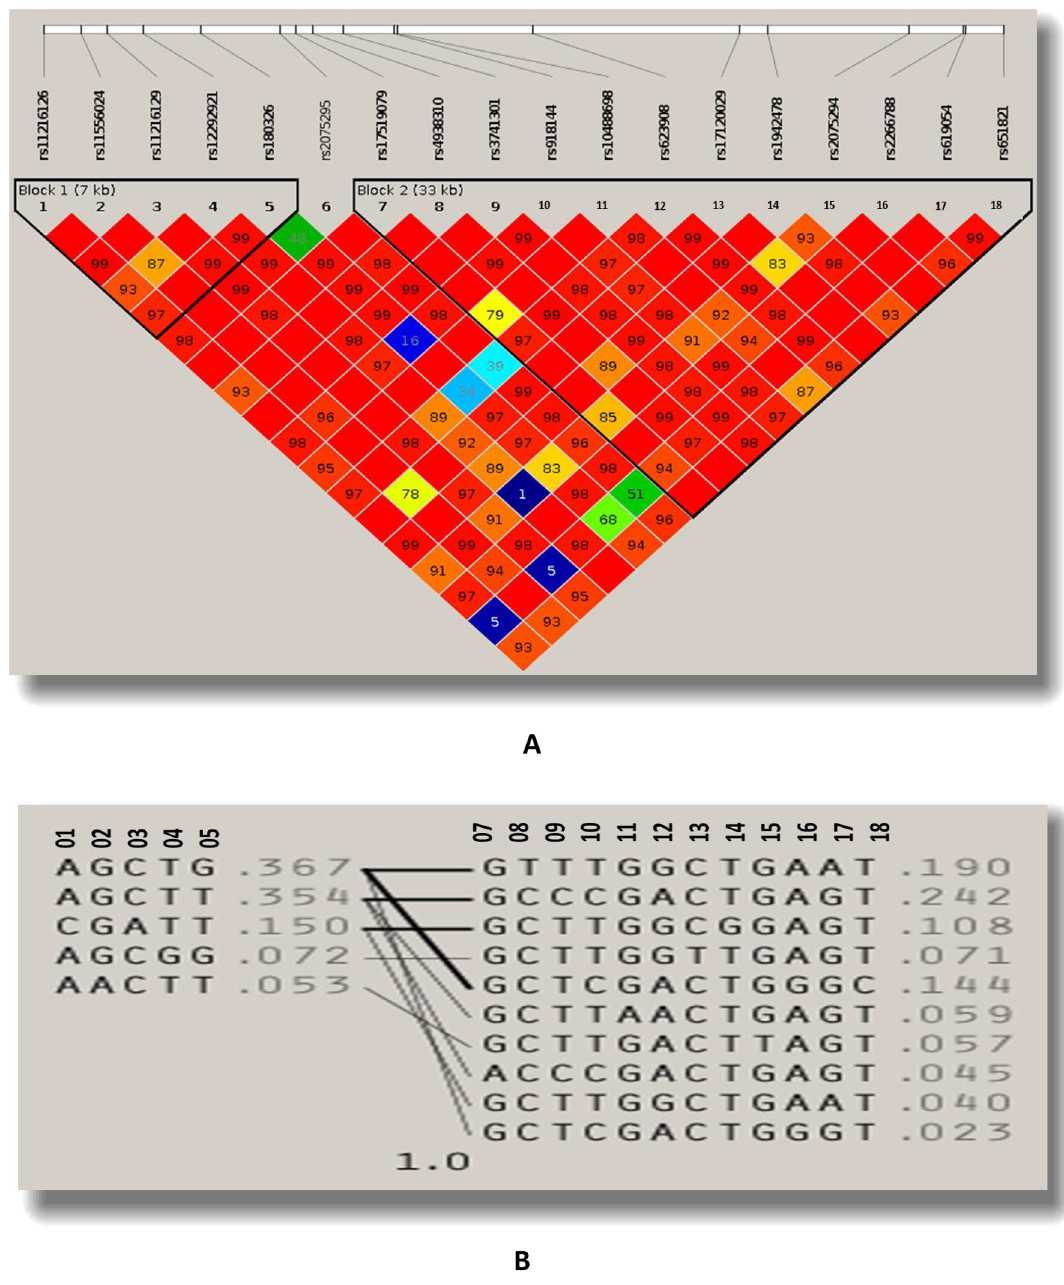
Figure 1. Linkage Disequilibrium blocks of 18 tag SNPs of BUD13/ZPR1/APOA5 in the chromosomal region (11q23.3) (3.3 Kb) according to four gamete rules, LD plot of Haploview software 2(A) and Haplotypes